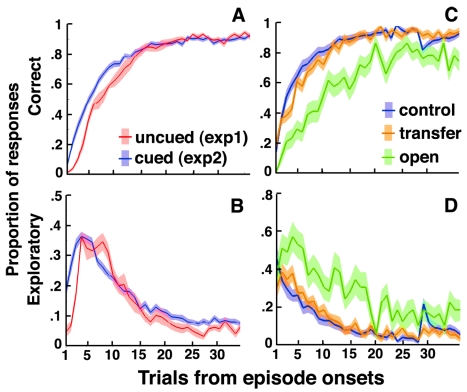
Human decisions with contextual cues.Participants' performances are plotted against the number of trials following episode onsets. Shaded areas are S.E.M. across participants. (A and B) Correct and exploratory response rates in uncued (red) and cued (blue) recurrent episodes. Uncued recurrent episodes are from Experiment 1 for participants who performed the recurrent session before the open session (half of participants). Cued recurrent episodes correspond to the first session of the second experiment. (C and D) Correct and exploratory response rates in control (blue), transfer (orange), and open (green) episodes (second experiment, second session). In control episodes, the drop of correct response rates and the peak of exploratory response rates visible on Trial 29 corresponded to contextual cue changes while external contingencies remained unchanged (see Figure S3).